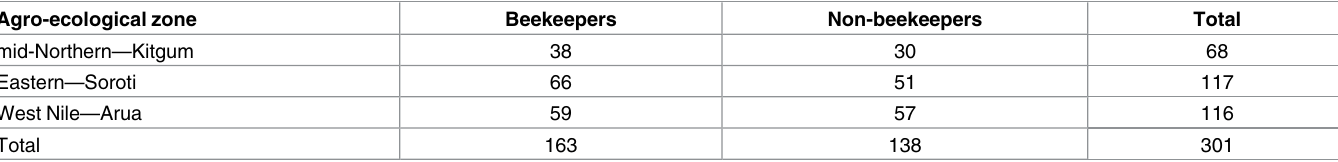
Table 1. Summaryof sampled households with number of beekeepers and non-beekeepers in the three agro-ecological zones in Uganda for this study. Agro-ecological